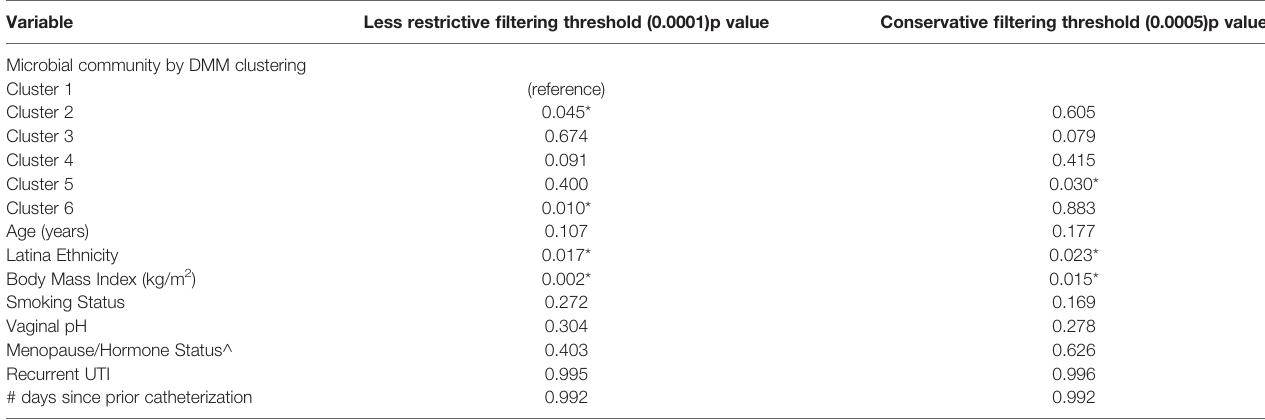
TABLE 3 | Updated analysis multivariable model testing for associations between MUI versus control.